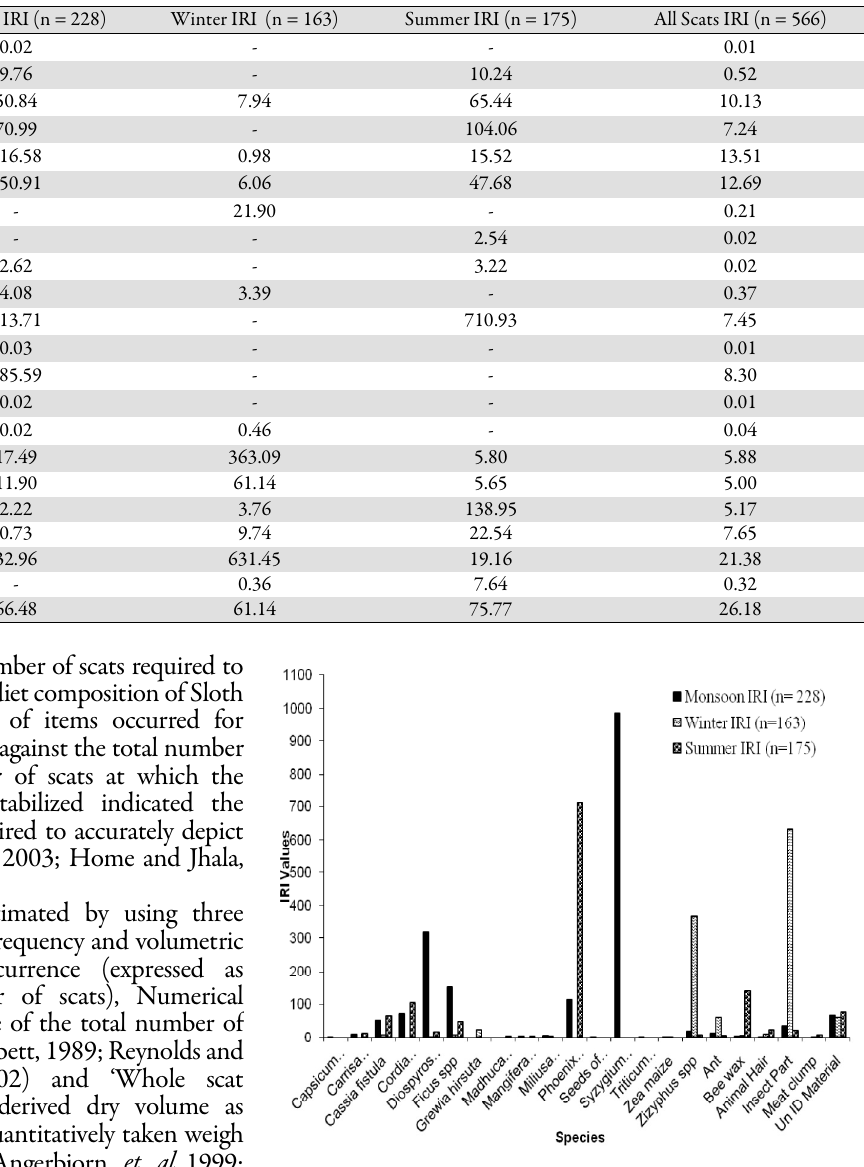
Fig. 1. Differences in the Sloth bear diet among three different seasons; Comparison of IRI scores between monsoon, winter and